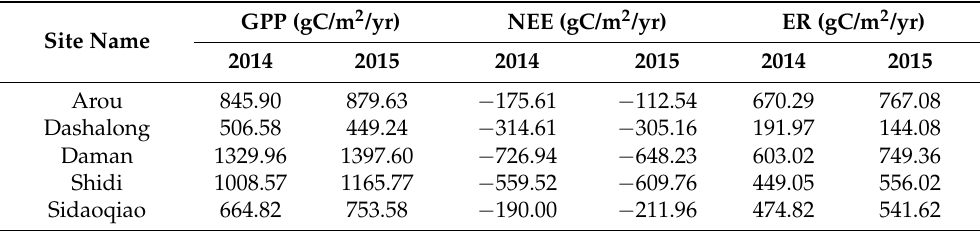
Table 3. Annual carbon flux at the five study sites in the Heihe River